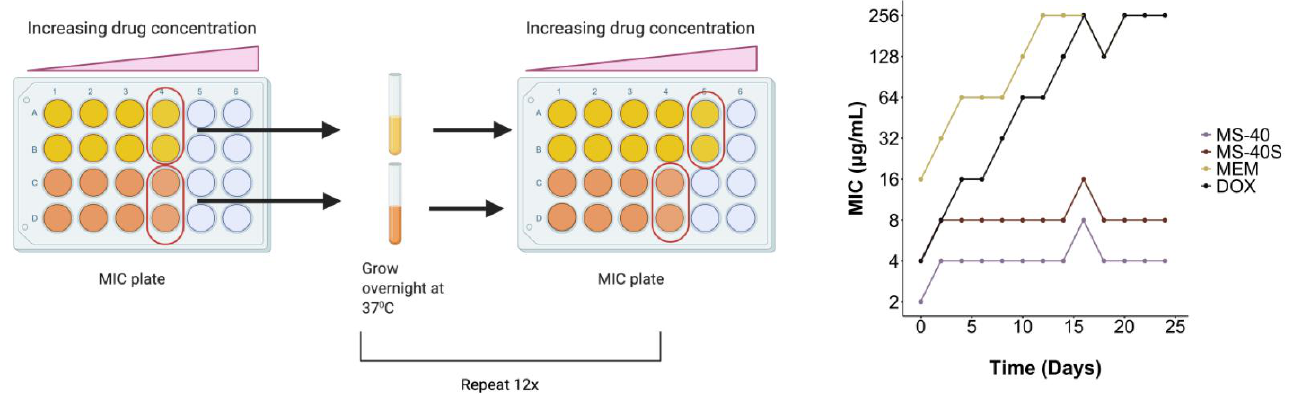
Figure 2. Resistance is not generated to MS-40S. Repeated exposure of a continuously grown culture to sub-lethal concen- trations of the antimicrobials were achieved by determining the MIC of the compound. Then, for each compound, 30 µ L of bacteria from the well with growth with the highest concentration of compound was grown overnight and used in the next MIC test. This was repeated over 24 days, with the MIC tested every second day. MEM, meropenem; DOX,